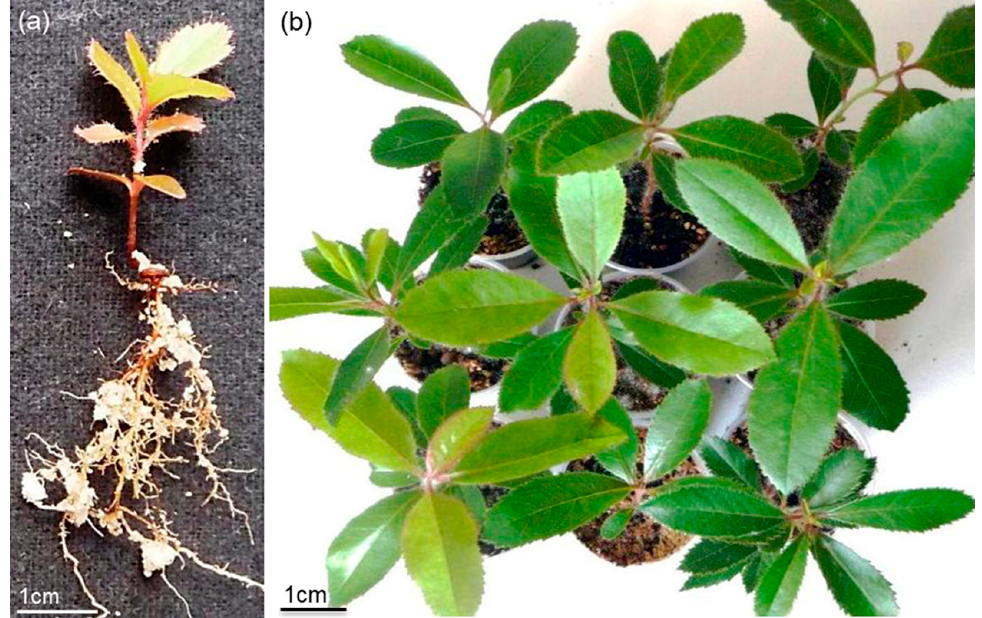
Figure 6. Strawberry tree hybrid plants development: ( a ) two-month-old hybrid seedlings; ( b ) six- month-old hybrid plants with distinct morphological characteristics.